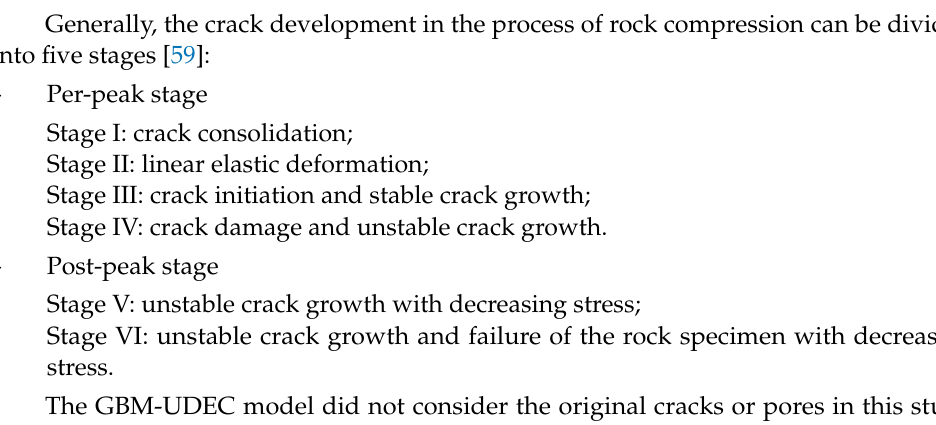
Figure 10. Stress–strain and AE curves of the numerical model rock.